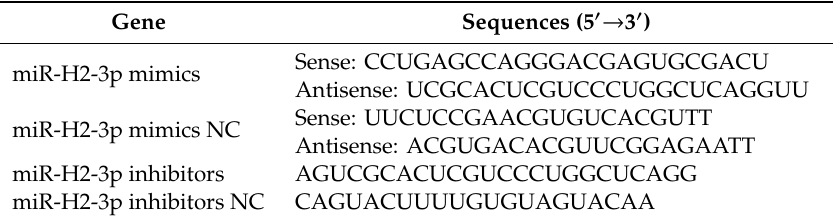
Table 3. The miRNA mimics and inhibitor